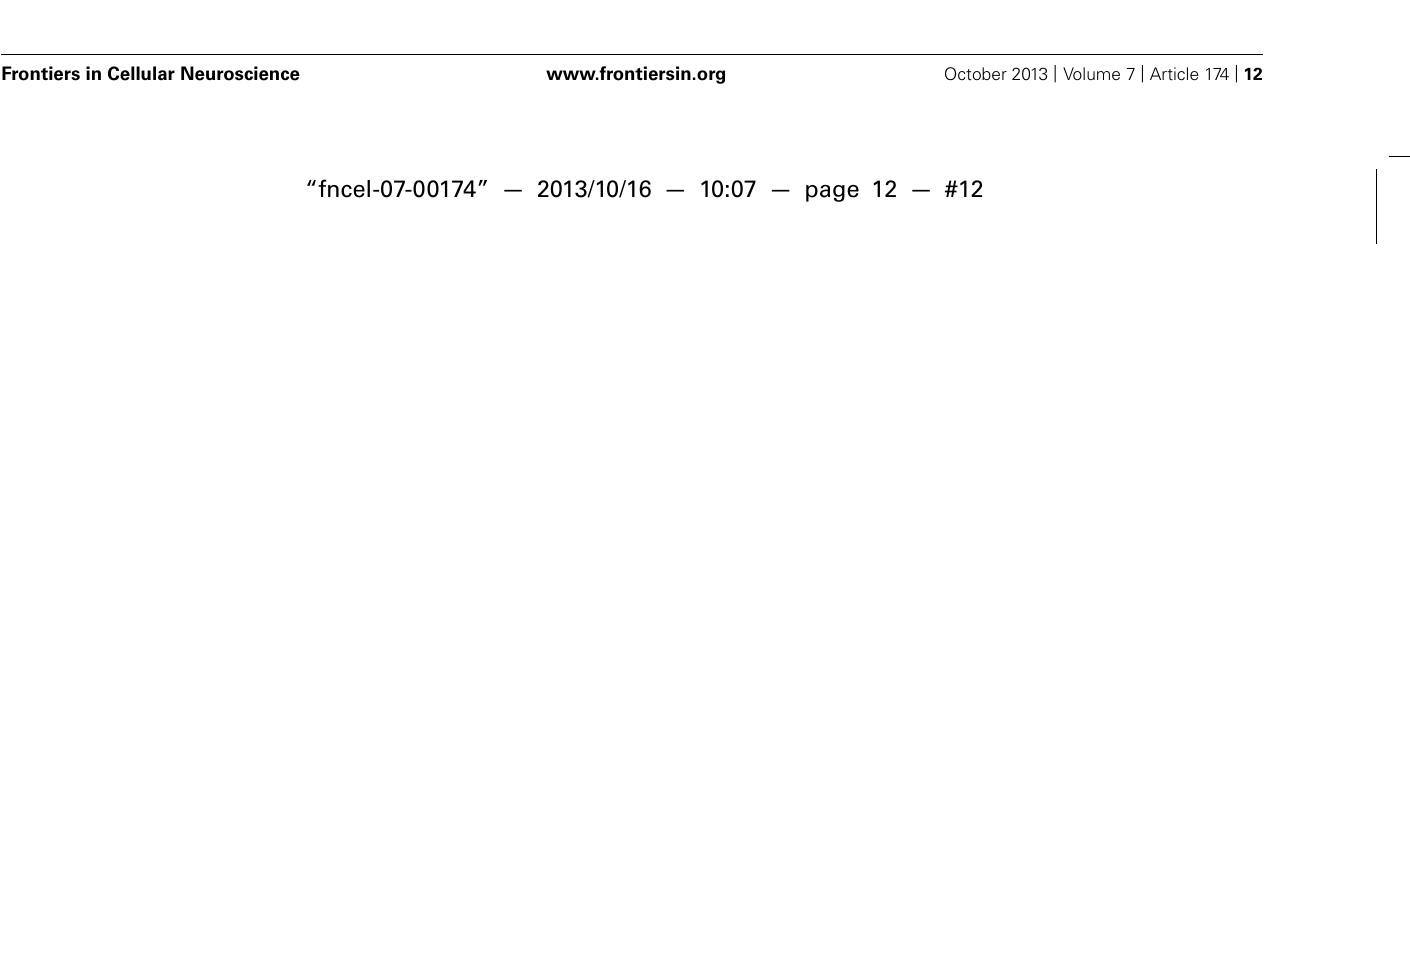
Horizontal gray bars indicate group-wise differences at the 5% significance level (Kruskal-Wallis test and Dunn’s post hoc analysis). (D, E) Paired comparison of the same parameters at 26 and 36 ◦ C. Relationship between firing frequency adaptation and sag at 26 ◦ C (F) and 36 ◦ C (G) , showing the largest I H sag in the CTh and CSp subgroups consistent with their regular firing behavior (see Figure 3 ) and the smallest I H sag and robust adaptation in the CStr and CC